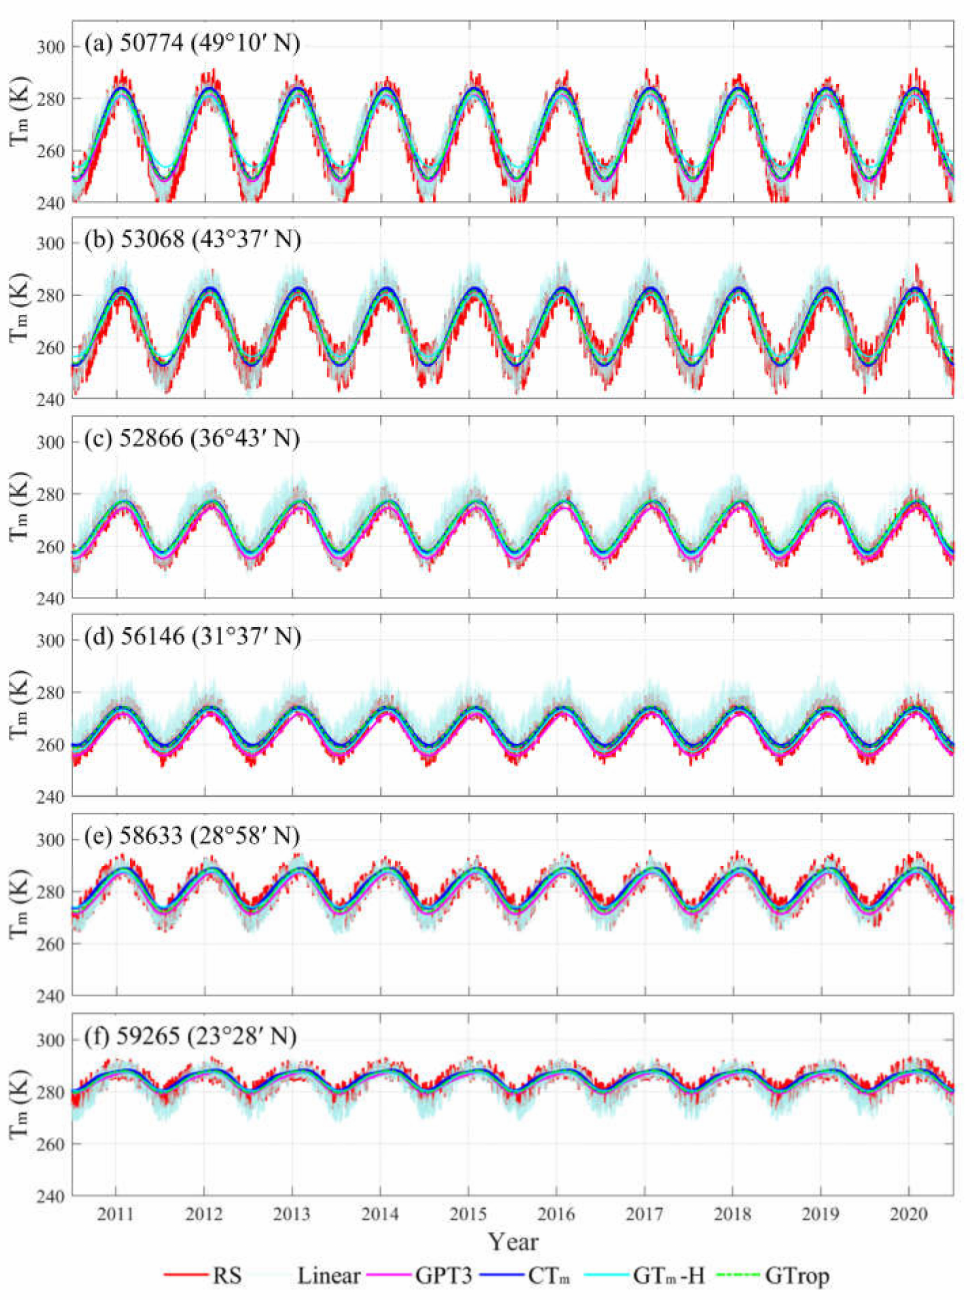
Figure 4. Time series comparison of the five T m models and the RS-derived T m at six stations distributed in different latitudes over the period of 2011 to